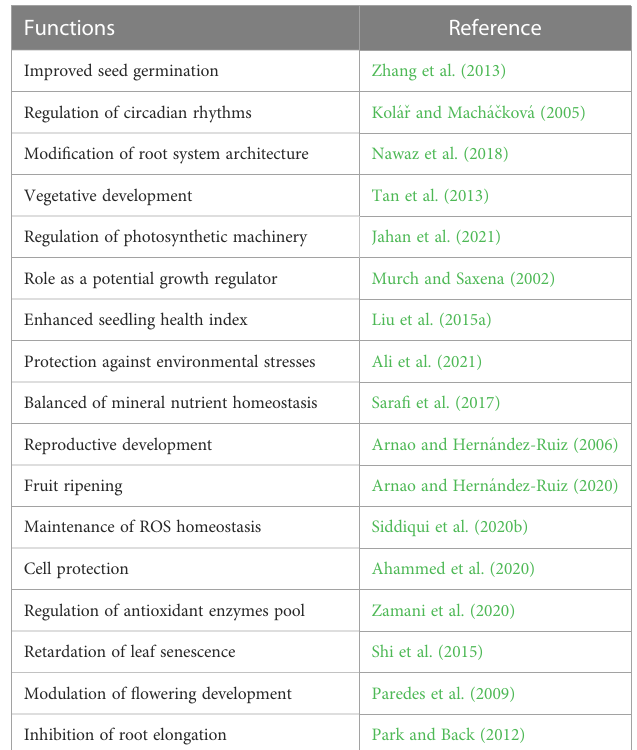
TABLE 2 Function of melatonin in horticultural